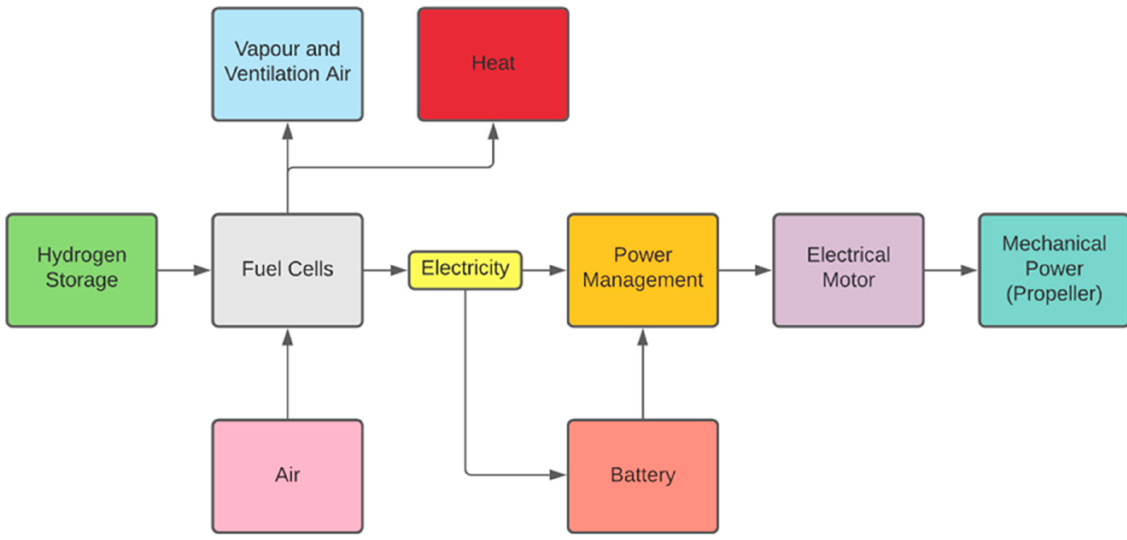
Figure 1. Hybrid (fuel cell/battery) hydrogen-powered propulsion system. Table 2. Energy density of diesel compared to different hydrogen (H) fuel states (data from [2]).